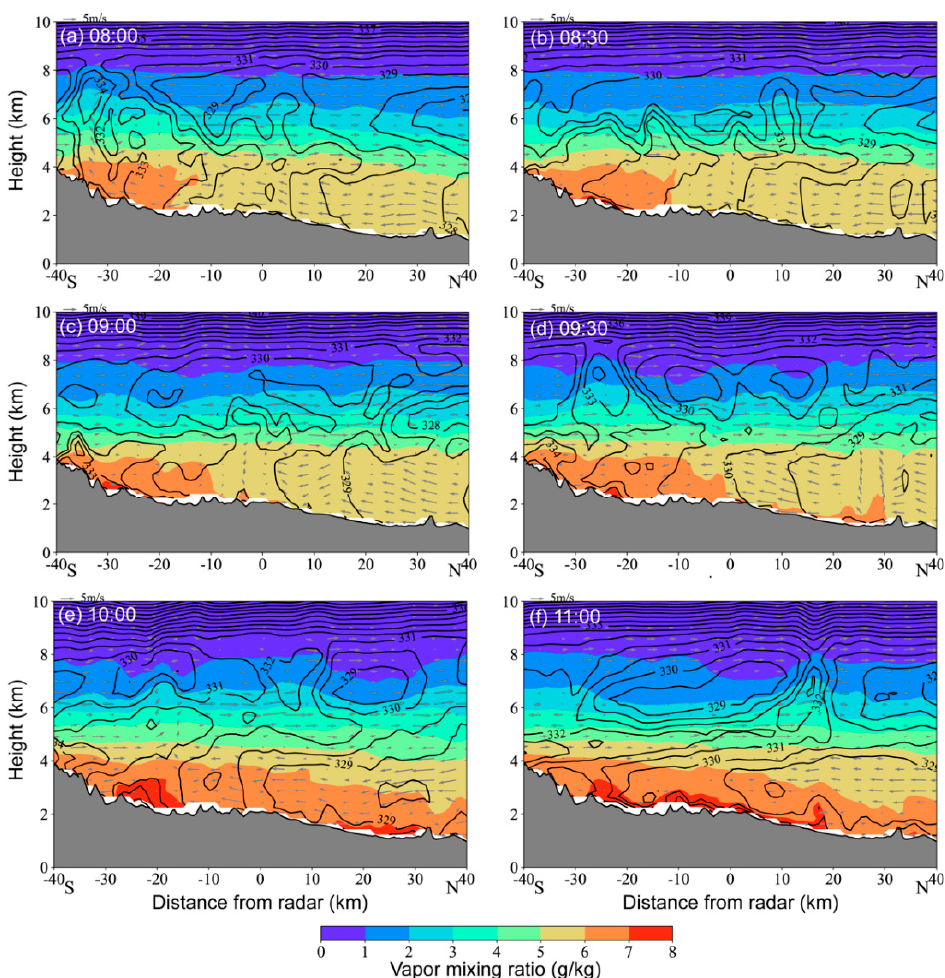
Figure 12. Modeled cross − section of equivalent potential temperature (contours), wind field (gray vectors), and water vapor mixing ratio (colored) along the east black line in Figure 10 for ( a − d ) segment 1, ( e ) segment 2, and ( f ) segment 3. S and N below each panel indicate south and north of the cloud radar.